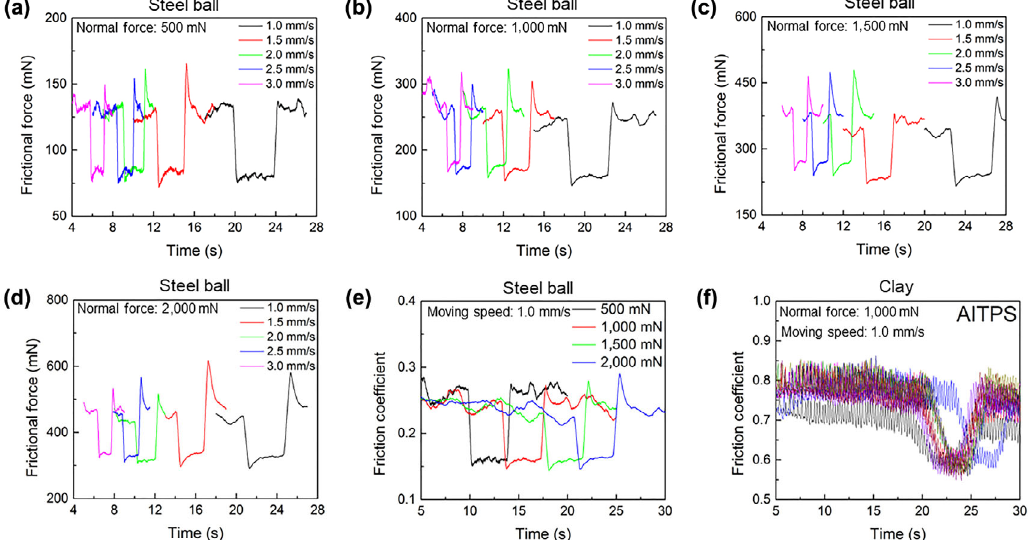
Fig. 4 Testing with smooth steel ball: (a–d) force–time curves of AITPS with different preloads (500, 1,000, 1,500, and 2,000 mN) and different sliding speeds (1.0, 1.5, 2.0, 2.5, and 3.0 mm/s); (e) friction coefficients of AITPS for different preloads with a moving speed of 1.0 mm/s. Testing with commercial clay: (f) friction coefficient curves of AITPS after 10 times of